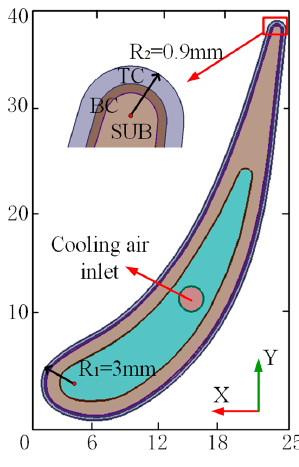
Figure 3. Section view (mm).